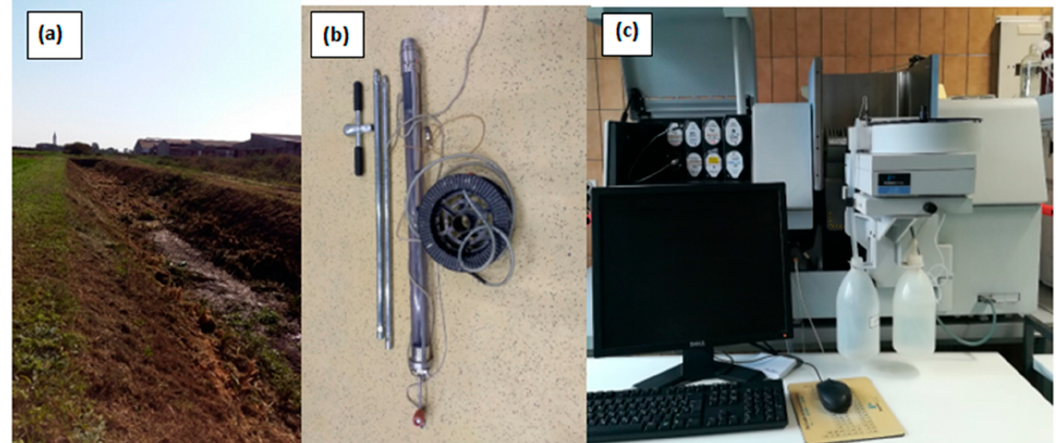
Figure 3. Sampling canal cross-section 3 – 3 ( a ), sediment core sampler (Beeker type ) ( b ), and graphite furnace atomic absorption spectrometer ( c ).